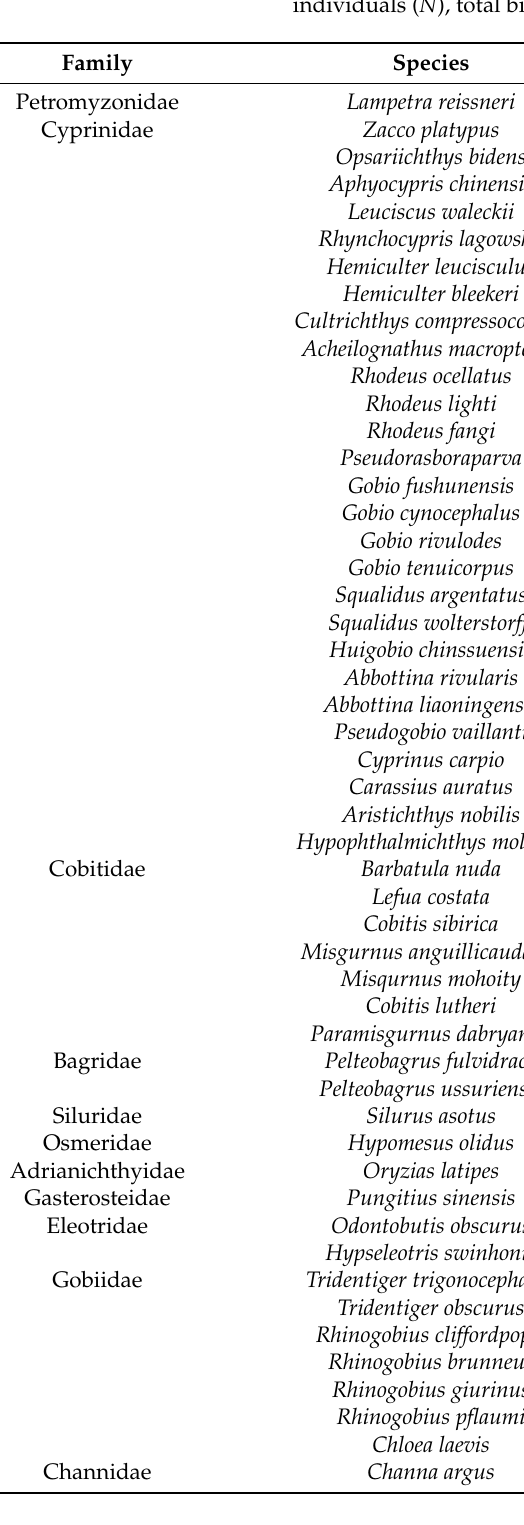
Table 2. The species composition of the fish in the Hun River Basin, showing the total number of individuals ( N ), total biomass ( W ) and index of relative importance ( IRI